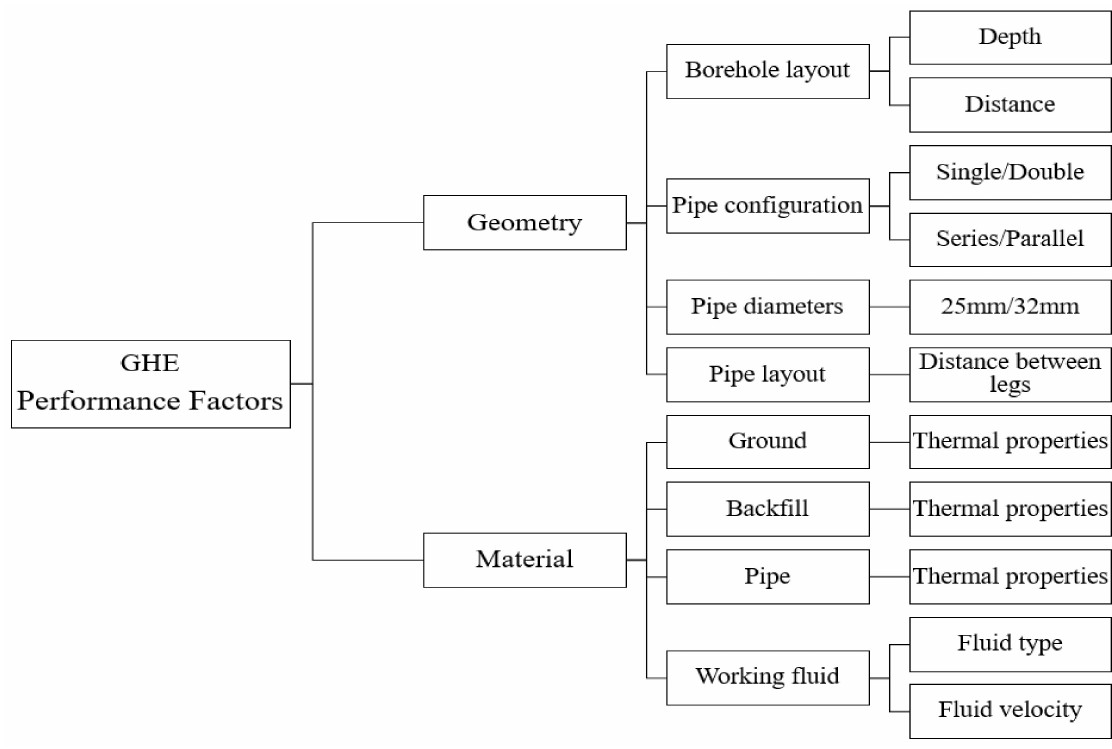
Figure 1. GHE’s thermal performance factors.